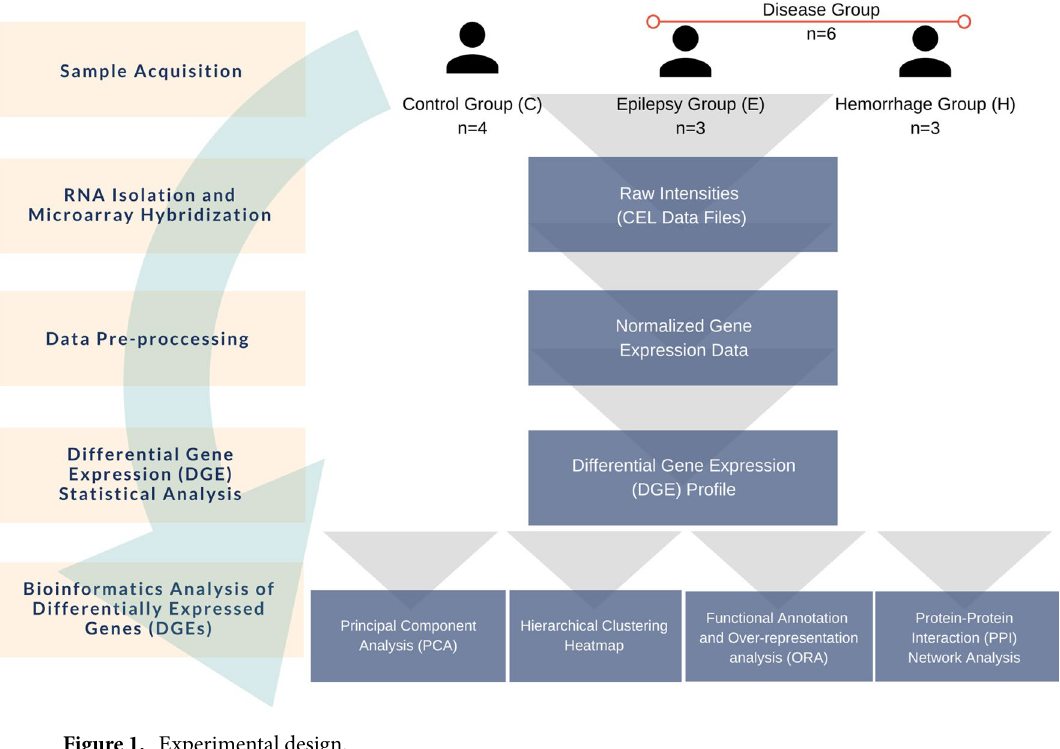
Figure 1. Experimental design.